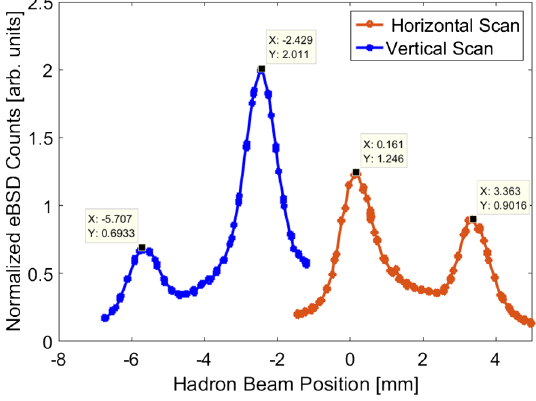
FIG. 8. Transverse beam alignment with the eBSD, with 40 mA dc beam.